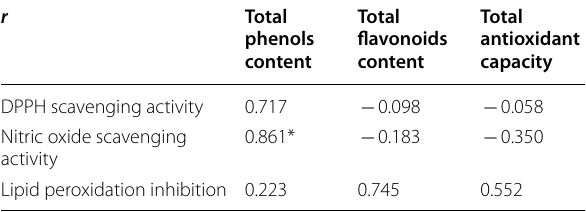
Table 4 Pearson’s correlation coefficients of C. albidum extracts antioxidant